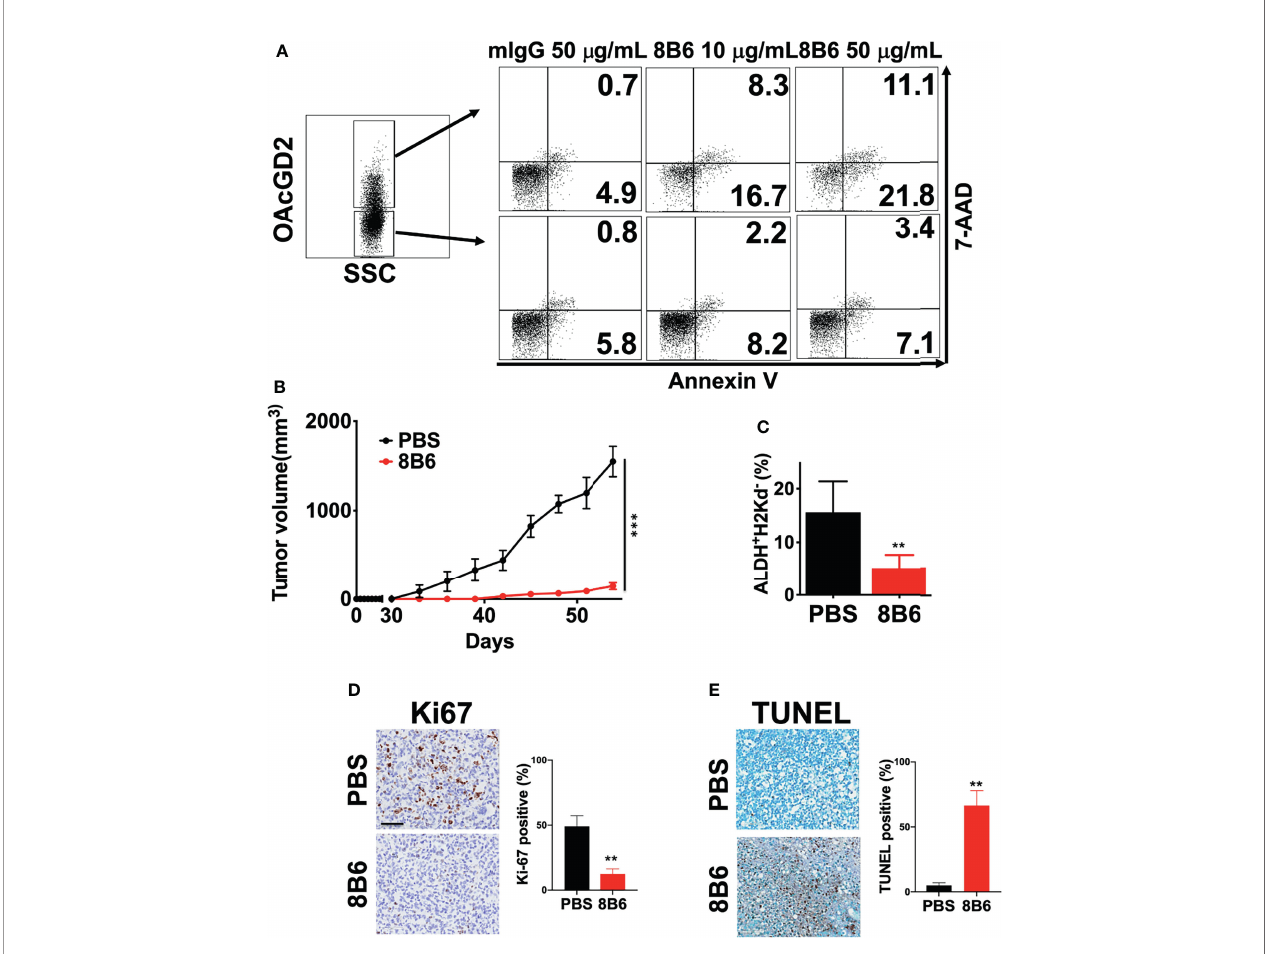
FIGURE 4 | MAb8B6 induces apoptosis in breast cancer cells harvested from PDXs in vitro and abrogates tumor growth of OAcGD2-expressing BCSCs in NOD/SCID mice. (A) Apoptosis of BC0244 cells after incubation with either 10 or 50 m g/ml of mAb8B6 or mIgG antibody for 24 h was determined by staining with 7-AAD and Annexin V-PE. (B) Inhibition of in vivo tumor growth of BCSCs sorted from BC0244 in NOD/SCID mice by mAb8B6. Mice (n = 6/group) were inoculated with sorted 1 × 10 5 OAcGD2 + ALDH + BC0244 cells at the mammary fat pad. Once the tumor volume reached 100 mm 3 , mice were treated with PBS or mAb8B6 (5 mg/kg) weekly ×4. Tumor volumes were measured every 3 days, and average of the tumor volumes for each group was presented. Tumors were completely abrogated in 3/6 mice treated with mAb8D6. (C) Four weeks after tumor inoculation, the BCSCs in BC0244-derived tumors was determined by fl ow cytometry with ALDEFLUOR ™ kit and mouse H2K d . (D) Ki67 and (E) TUNEL staining of tumor sections after mAb8B6 treatment. Scale bars, 60 m m. Ki67- and TUNEL-staining-positive cells were counted, and the percentage of positive cells out of the total number of cancer cells was calculated. ** p < 0.01, *** p <0.001 by Student ’ s